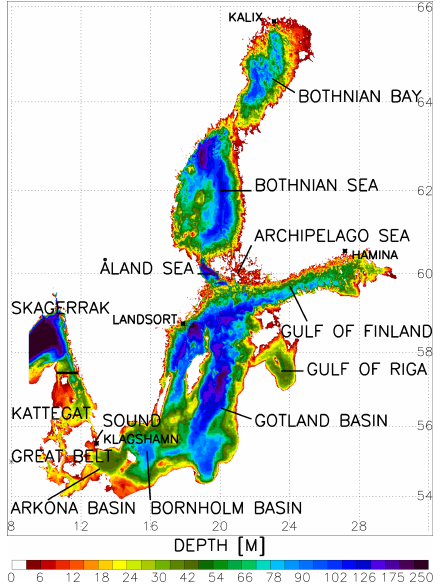
Figure 1. Bottom topography of the Baltic Sea (depth in metres). The Baltic Proper comprises the Arkona Basin, Bornholm Basin and Gotland Basin. The border of the analysed domain of the Baltic Sea models is shown as a black line in the northern Kattegat. The tide gauges in Klagshamn (55.522 ◦ N, 12.894 ◦ E), Landsort (58.742 ◦ N, 17.865 ◦ E), Hamina (60.563 ◦ N, 27.179 ◦ E) and Kalix (65.697 ◦ N, 23.096 ◦ E) are also